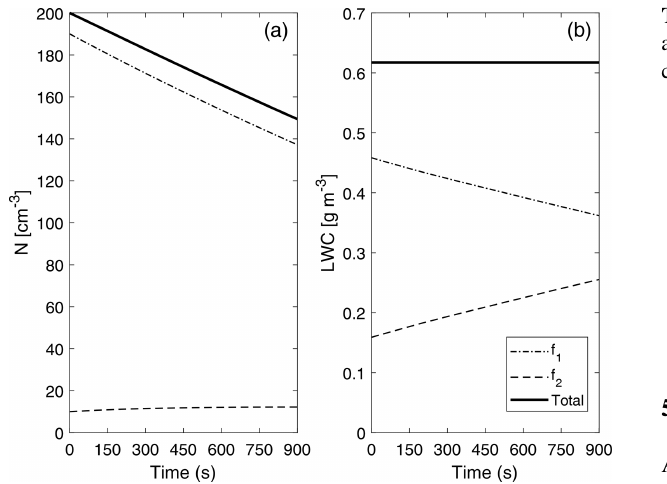
Figure 10. Evolution of drop number concentration N (a) and liquid water content (LWC) (b) of the individual distributions that form P- DNN. The liquid water content of each of the distribution functions ( f 1 and f 2 ) was obtained from the corresponding moment (order 3) calculated from Eq. (4). The combined (total) values of the variables are also shown and were calculated from Eq. (5).